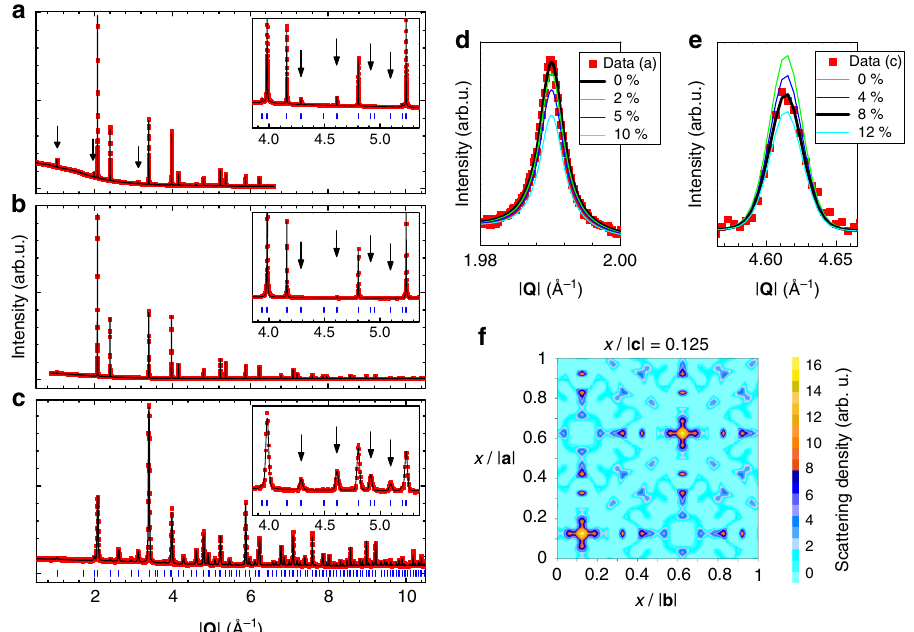
Fig. 2 Crystallographic characterization of Tb 2 Hf 2 O 7 from powder samples. a – c Final Rietveld plots of the joint re fi nement of high-resolution synchrotron X-ray a , b and neutron c powder diffraction data. The X-ray patterns were recorded using incident wavelengths of a 1.65304 Å (i.e., about 10 eV lower than the L 3 X-ray absorption edge of Tb, which provides a signi fi cant contribution of the anomalous terms to the X-ray scattering factor of Tb) and b 0.49599 Å (an energy that minimizes the absorption). The neutron pattern c was measured with a wavelength 1.155 Å on a large angular range detector, which yields an excellent sensitivity to the thermal displacement factors in general and to the occupancy factors of the different oxygen sites in particular. Arrows indicate some of the satellite re fl ections originating from the pyrochlore superstructure relative to a defective fl uorite phase due to both the disorder-free long-range order of Tb(16 d ) and Hf(16 c ) cations, and to the partially disordered long-range order of oxygen atoms in 8 b sites and oxygen vacancies in 8 a sites. d , e show the pyrochlore superstructure re fl ections (311) and (553) from the data of a , c respectively, compared to calculations for various densities of antisite cation disorder ( d the percentage indicates the fraction of Tb cations occupying the Hf site and vice versa) and anion Frenkel disorder ( e the percentage indicates the fraction of vacancies on the 48 f position). f Defects as they appear in a difference Fourier map plotted in fractional coordinates x of the crystallographic directions of the cubic unit cell. The map is obtained from the high-resolution neutron powder diffraction data in the case of a re fi nement to a perfect pyrochlore model (i.e., without oxygen Frenkel pair defects). Additional scattering density is clearly observed around the 8 a position (0.125, 0.125, 0.125), i.e., at crystallographic positions that are normally vacant in pyrochlore